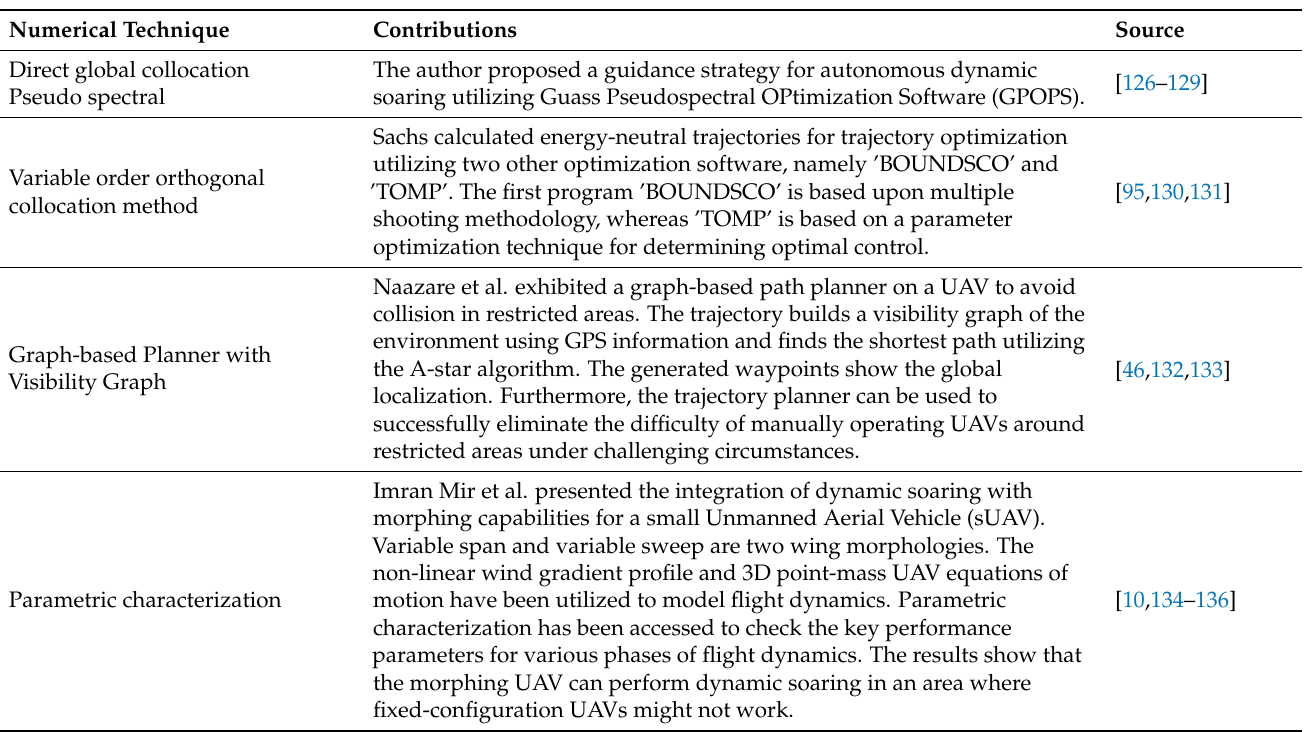
Table 3. A summary of numerical techniques involved in aerial, ground, and underwater vehicle